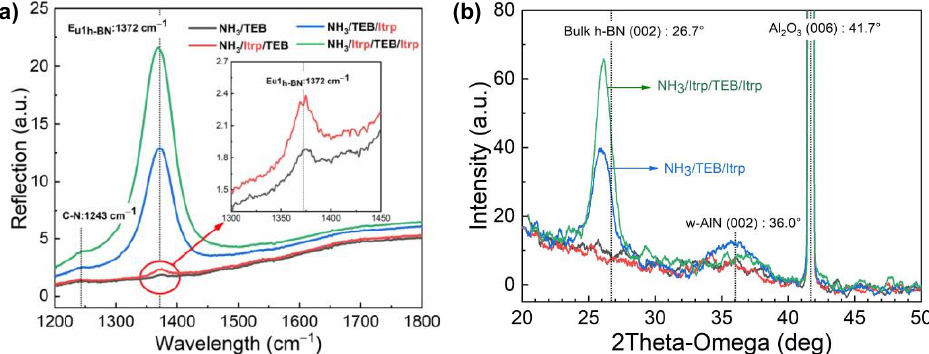
Figure 3. ( a ) FTIR spectra and ( b ) XRD 2theta-omega scans of the h-BN films with fixed 150 growth loops under four FME modes. The inset is magnified spectra in the red circle in ( a ).